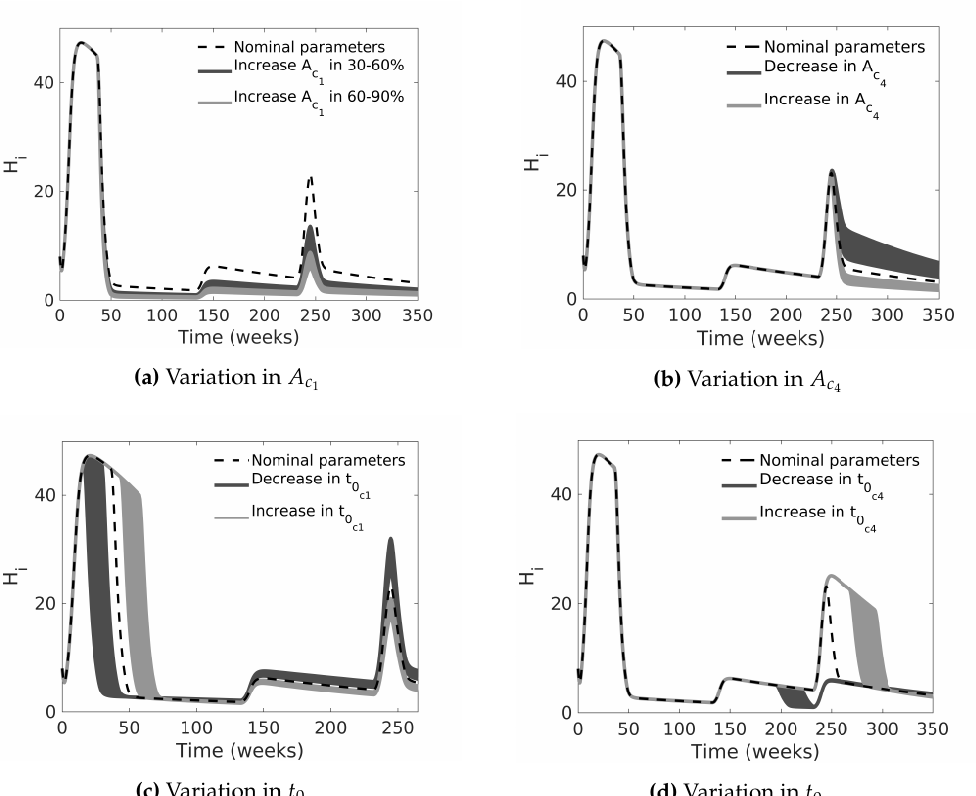
Figure 7. Monte Carlo simulations of the dengue transmission model for the number of infected humans in two scenarios: ( a ) increasing the value of A c value; ( b ) increasing and decreasing the value of A C ( c , d ) late and early chemical control, increasing or decreasing t 0 10–20% of their nominal values, respectively. For each scenario, we performed 1000 simulations.